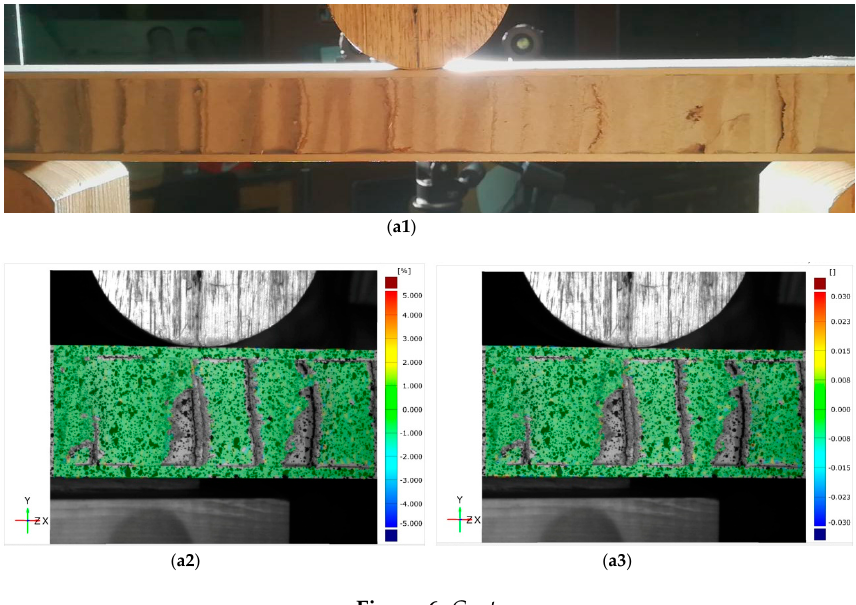
Figure 5. Typical load-displacement curve of indentation process of wooden sandwich beam with Taiji honeycomb core (A1B3C3): ( a ) unloaded; ( b ) initiation of indentation; ( c ) showing condition after indentation.